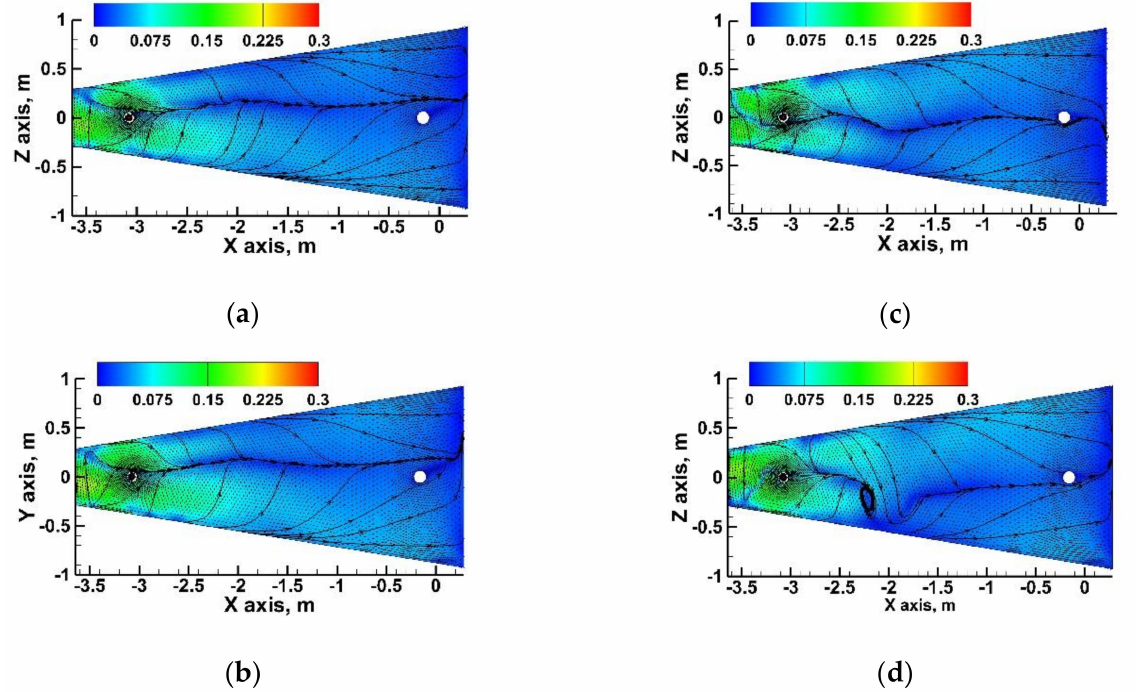
Figure 14. Behavior of liquid steel flow near the tundish flux-steel interface: ( a ) tundish with SFC No. 2C105 and casting speed 1.0 m/min, ( b ) tundish with SFC No. 2C105 and casting speed 1.1 m/min, ( c ) tundish with SFC No. 3C105 and casting speed 1.0 m/min, ( d ) tundish with SFC No. 3C105 and casting speed 1.1